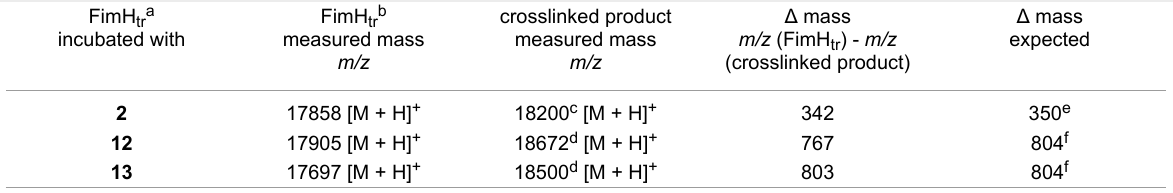
Table 2: Results of mass spectrometric analysis of photo-crosslinked products, obtained from irradiation of FimH tr with photoactive mannoside ligands 2 , 12 , and 13 . FimH tra incubated with